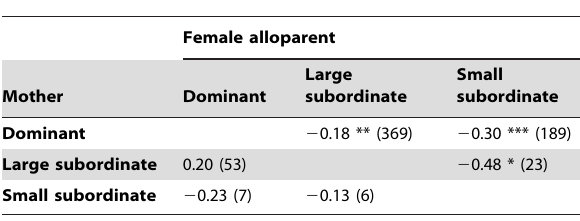
Table 2. Spearman rank correlations between the frequency of maternal brood care and frequency of alloparental care by other female group members, in brackets sample sizes (number of broods).